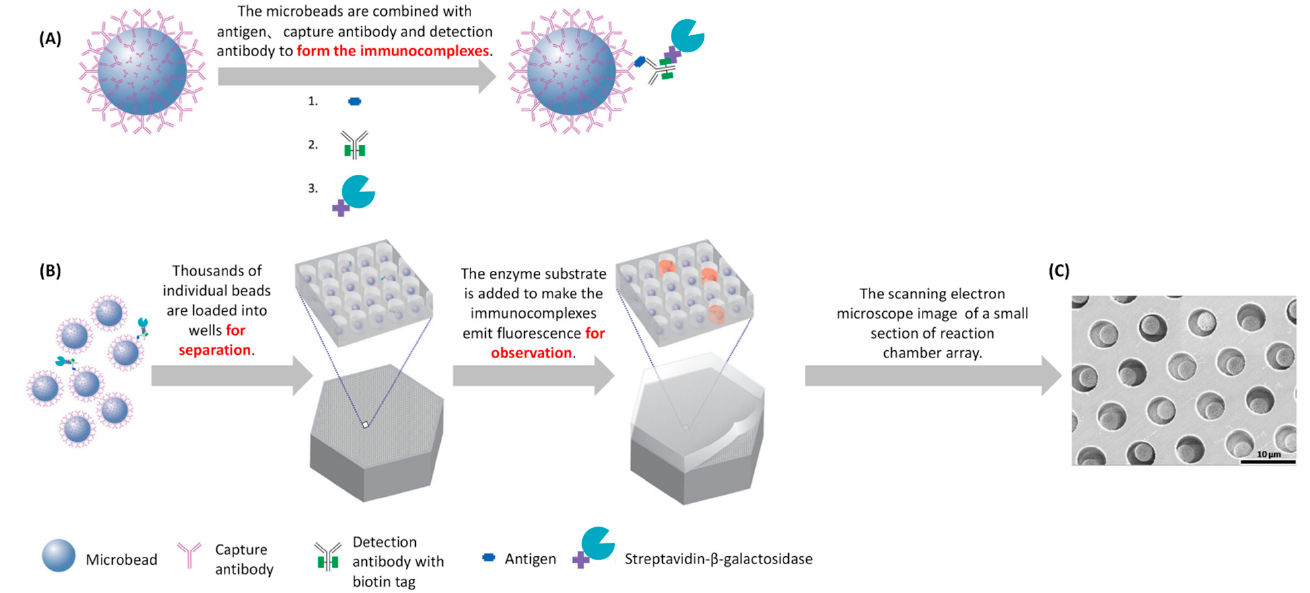
Figure 1. Single-molecule enzyme-linked immunosorbent assays (digital ELISA) based on singulation of enzyme labels. ( A ) Capturing and labeling individual protein molecules on microbeads using standard ELISA reagents. ( B ) Microspheres are loaded into a reaction chamber array for the separation and detection of individual molecules. ( C ) Scanning electron microscope image of the microspheres after placement in the reaction chamber array. Reprinted with permission from [29]. Copyright 2010 Springer Nature.